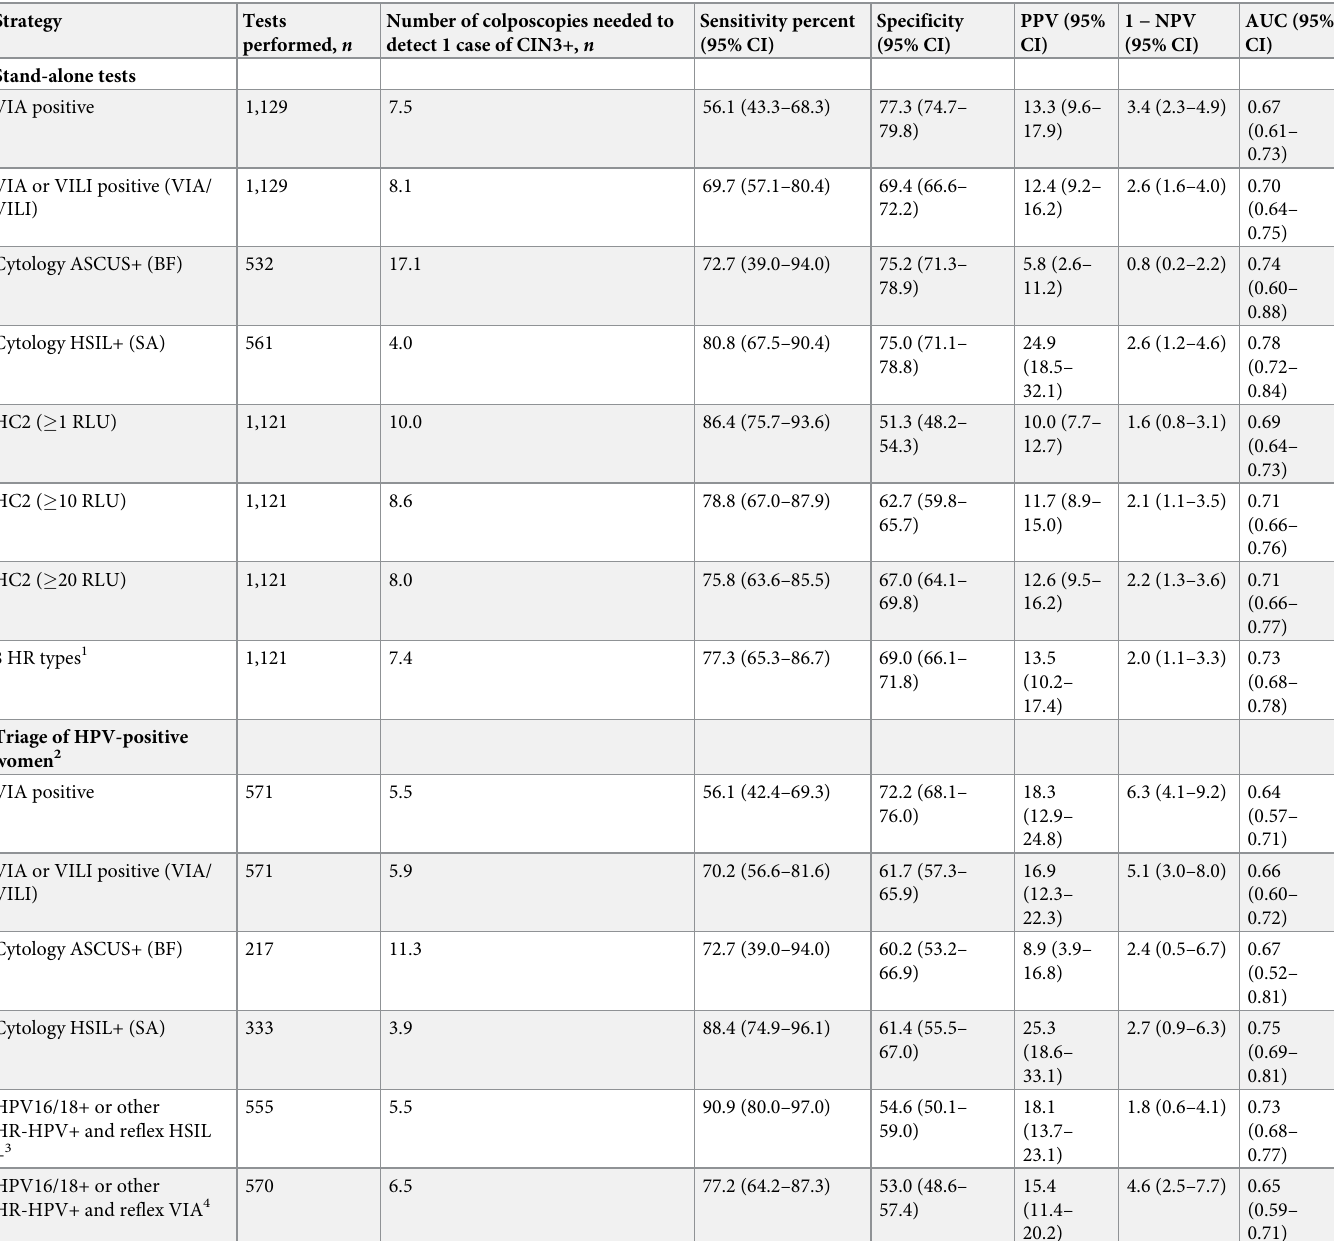
Table 3. Performance of screening strategies for detection of prevalent CIN3+ among 1,130 women living with HIV (554 in BF; 576 in SA).